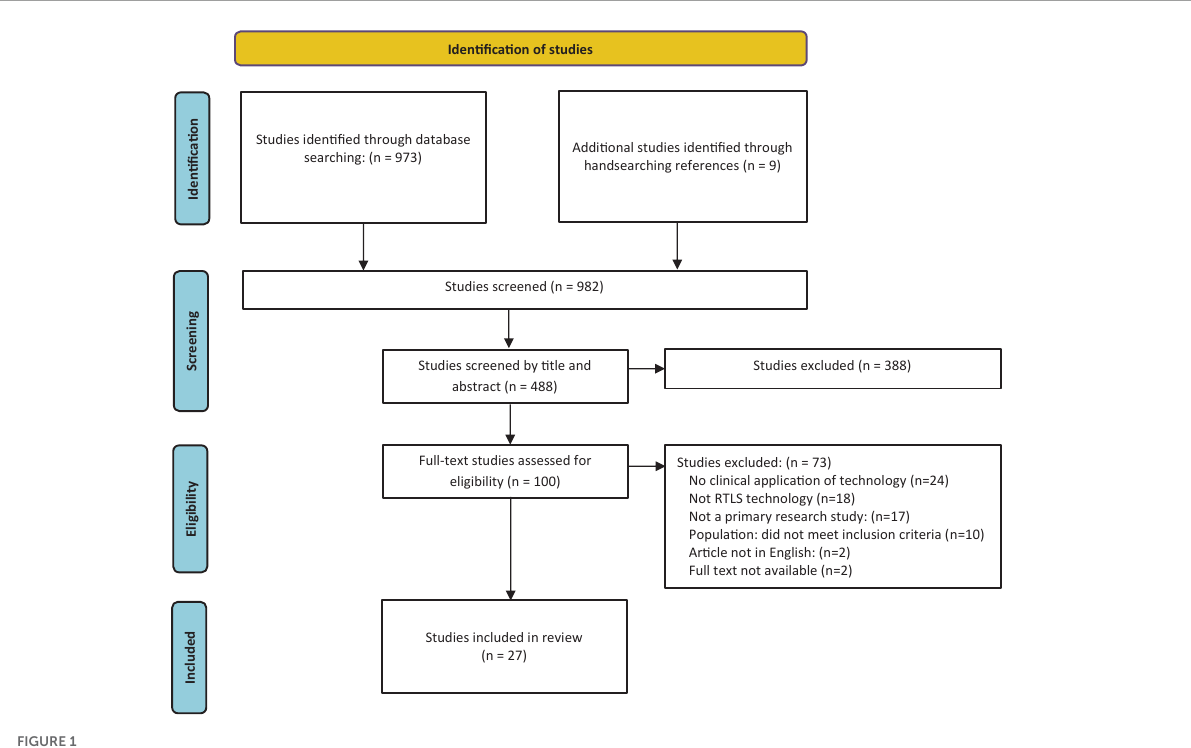
FIGURE1 Search results and study selection and inclusion process